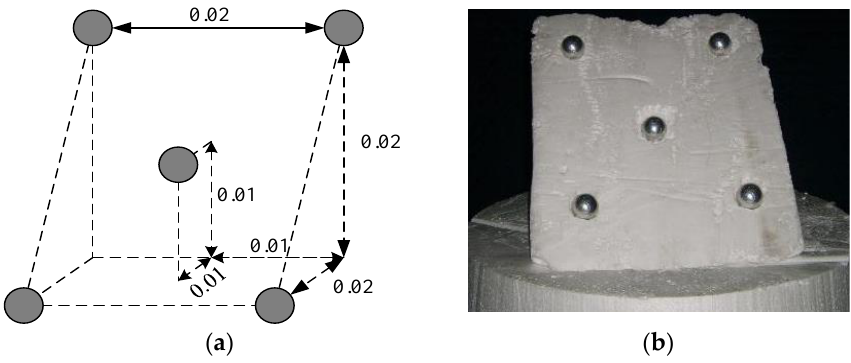
Figure 3. Target model of five metal balls. ( a ) 3-D spatial distribution; and ( b ) the photo in the anechoic chamber.